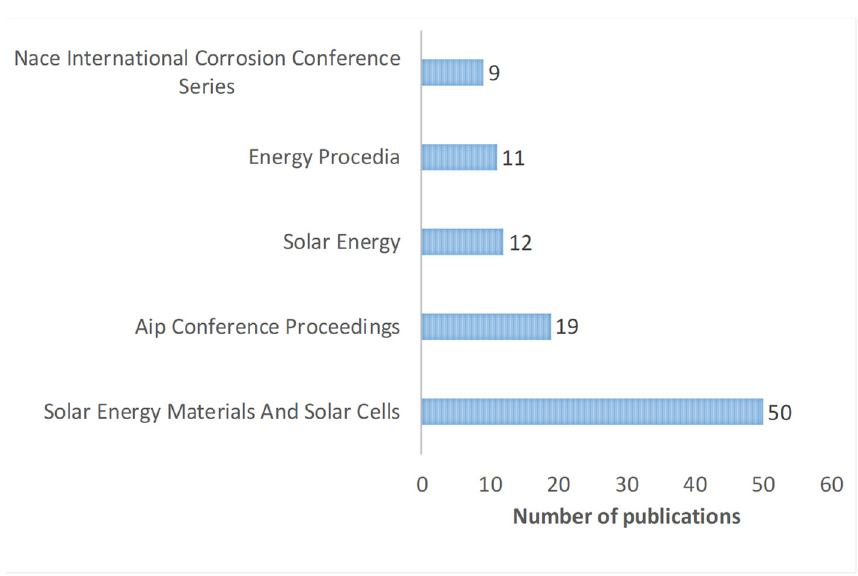
Figure 2. Main journals with publications about corrosion in CSP/STE.